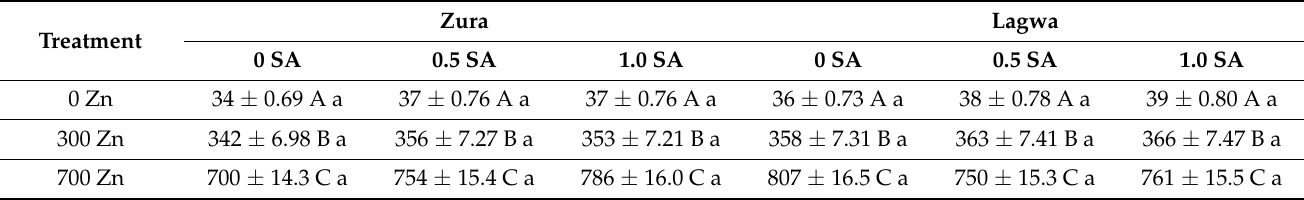
Table 2. Zn concentration in soil after harvest in mg kg − 1 ( ±